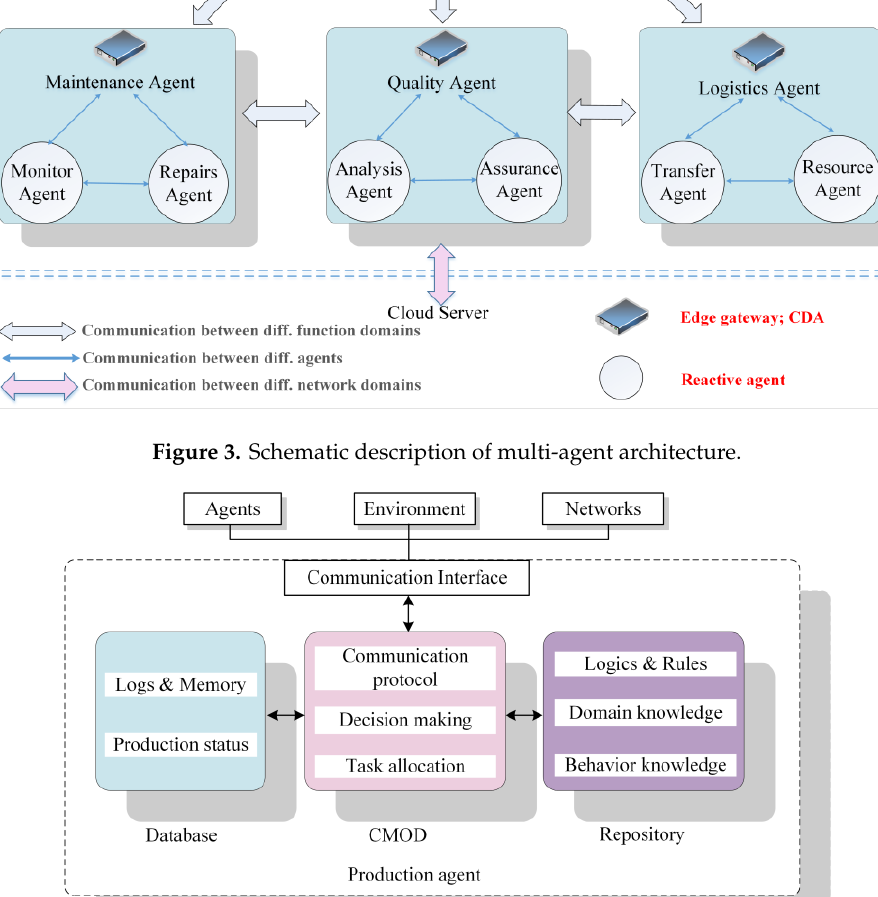
Figure 3. Schematic description of multi-agent architecture.